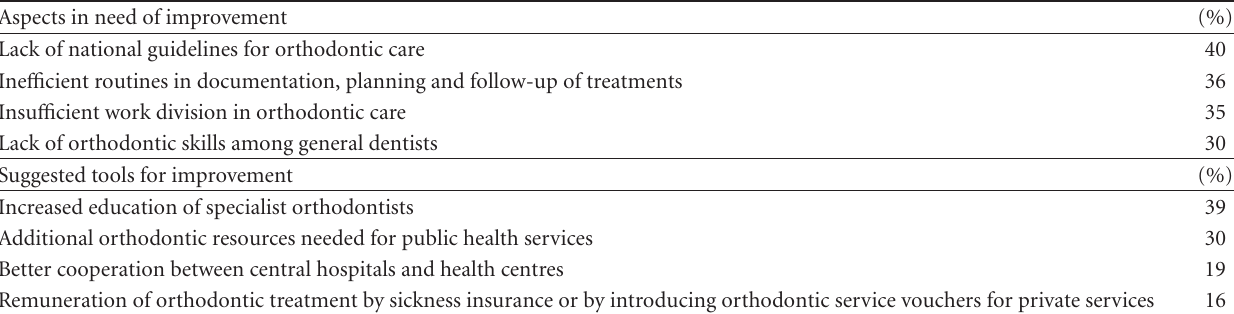
Table 5: Aspects in need of improvement and suggested tools for improvement according to specialist orthodontists (percentage of respondents in parenthesis).